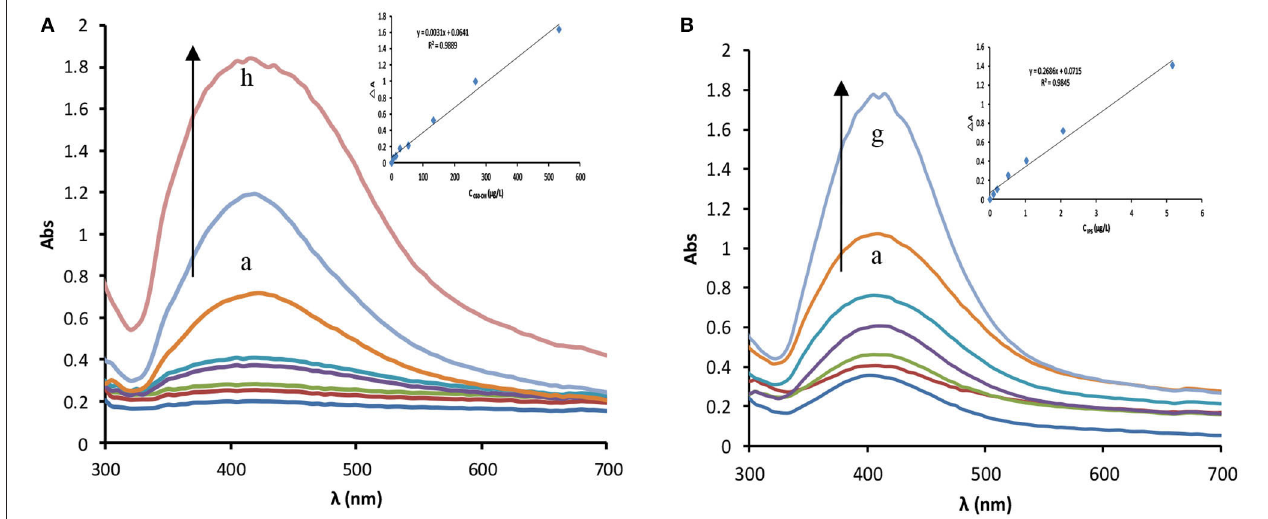
FIGURE 4 | Absorption spectra. (A) C 60 OH–AgNO 3 -TSC catalytic system, (0, 5.33, 13.33, 26.67, 53.33, 133.33, 266.67, 533.33 µ g/L) C 60 OH + 1.33 mmol/L AgNO 3 + 4.67 mmol/L TSC + 85 ◦ C + 21min + 3.33 × 10 − 7 mol/L VBB + 0.02 mol/L NaCl. (B) Apt–C 60 OH–AgNO 3 -TSC-IPS detection system, 20.67 nmol/L Apt + 266.67 µ g/L C